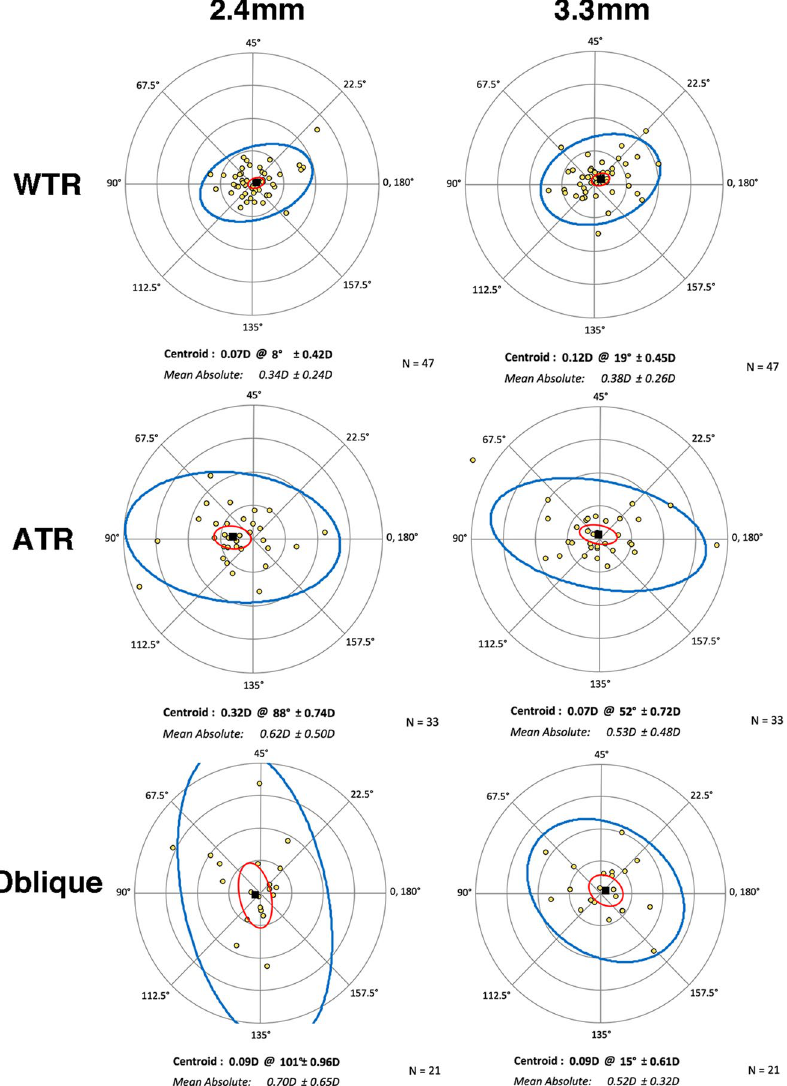
Figure 2. Double-angle plots of the astigmatism prediction error by diameter zone and astigmatism subgroup. The red and blue lines represent the 95% confidence ellipses of the centroid and dataset, respectively. These two 95% confidence ellipses are apparently smallest in the WTR subgroup. WTR with-the-rule, ATR against-the-